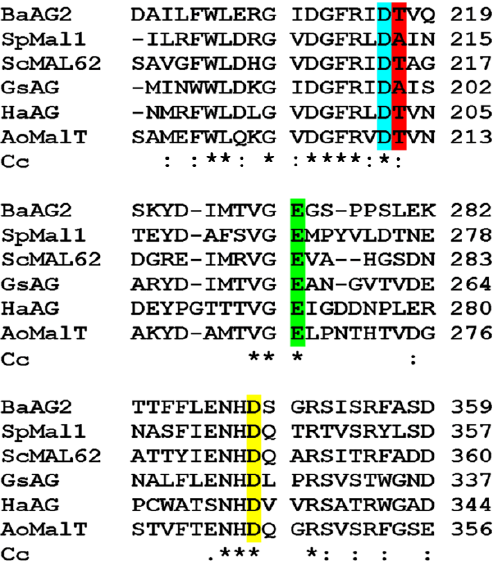
Figure 2. Fragments of sequence alignment of six maltases. Ba AG2, Blastobotrys adeninivorans AG2 (580 aa); Sp Mal1, Schizosaccharomyces pombe Mal1 (579 aa, NP_595063.1) [33]; Sc MAL62, Saccharomyces cerevisiae MAL62 (584 aa, P07265) [23]; Gs AG, Geobacillus stearothermophilus exo- α -1,4-glucosidase (555 aa, BAA12704.1) [34]; Ha AG, Halomonas sp. H11 α -glucosidase (538 aa, BAL49684.1) [35]; Ao MalT, Aspergillus oryzae maltase MalT (574 aa, XP_001825184.1) [36]. Highlights: catalytic nucleophile (turquoise), acid-base catalyst (green), a transition state stabilizer (yellow) and a residue crucial for substrate specificity (red). Cc, Clustal consensus. Marking below the sequence alignment is according to Clustal consensus showing conservation: * positions with fully conserved residue; : positions with residues of strongly similar properties; . positions with residues of weakly similar properties.